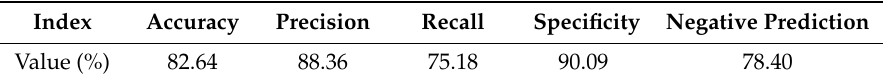
Table 6. Forecast evaluation index.